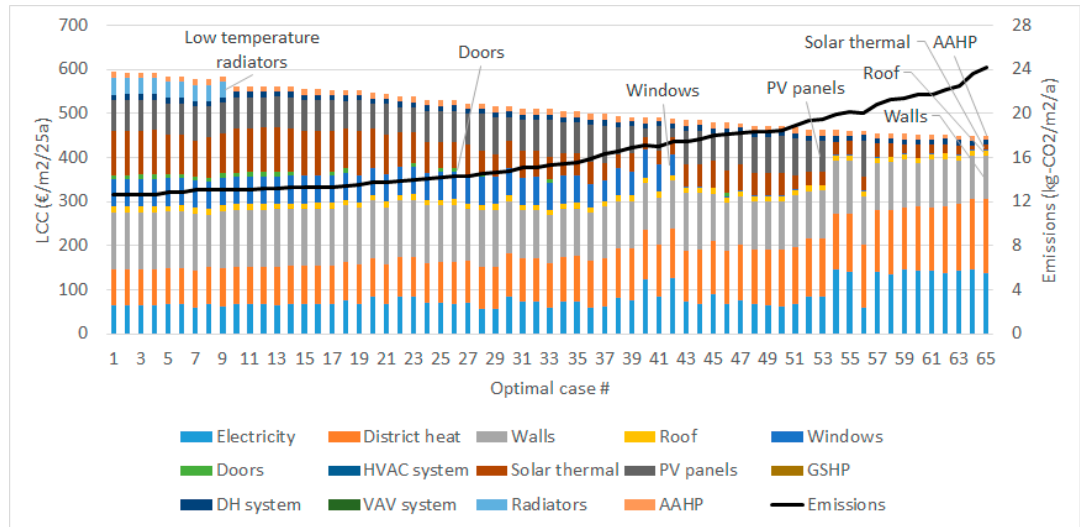
Figure 7. Breakdown of life cycle cost for SH1 with district heating.